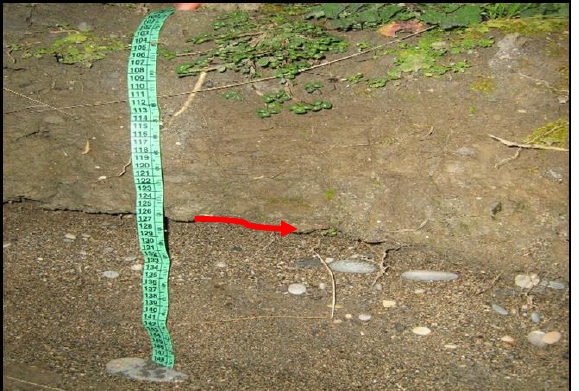
Figure 8. Transition of soil texture in a natural profile located near the site. Note the position of the red arrow where the soil texture transition takes place.